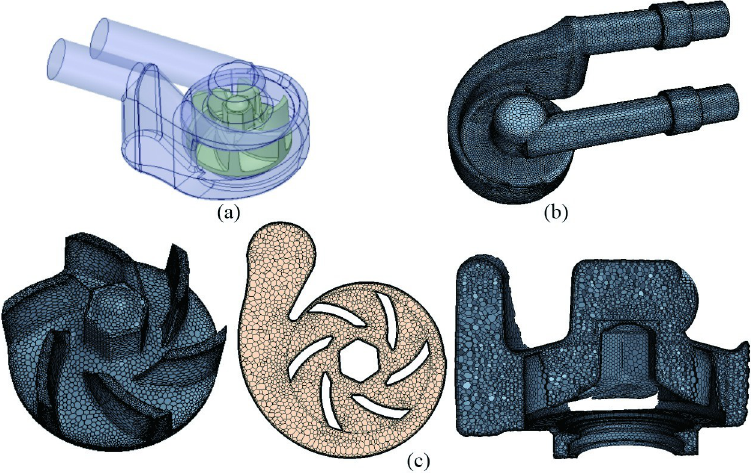
Fig 1. Computational region for engine cooling water pump: (a) Geometry model; (b) Mesh model; (c) Mesh